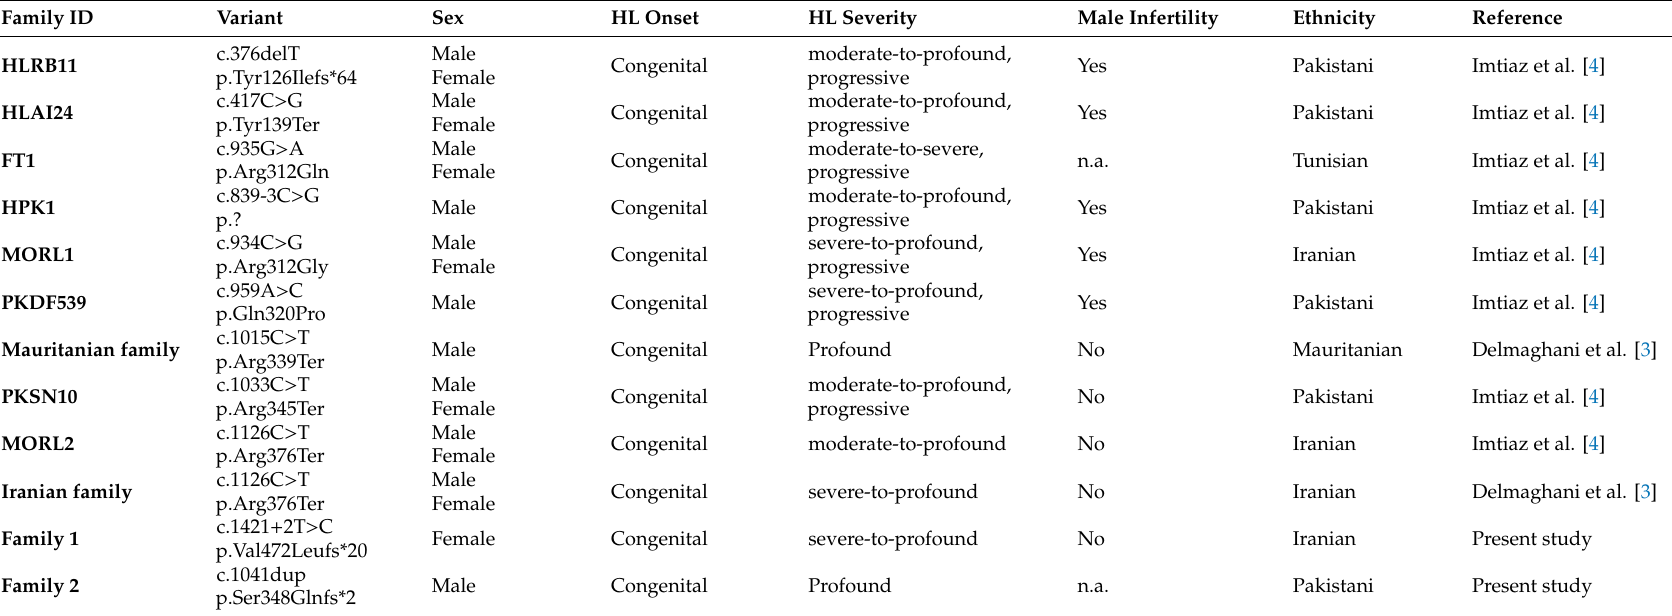
Table 1. Summary of previously described and newly identified families with homozygous variants in